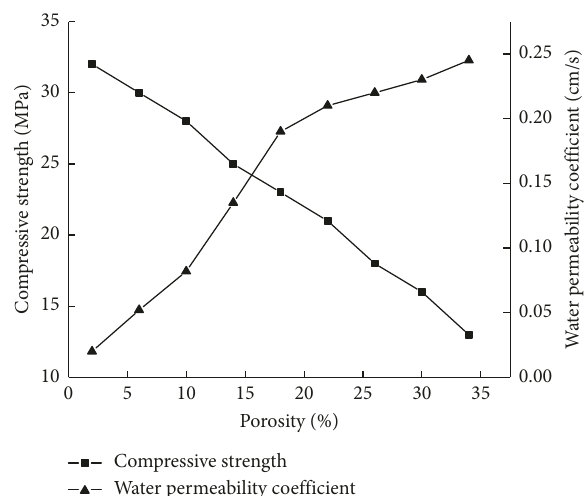
Figure 13: Comprehensive relationship between porosity, strength, and permeability.